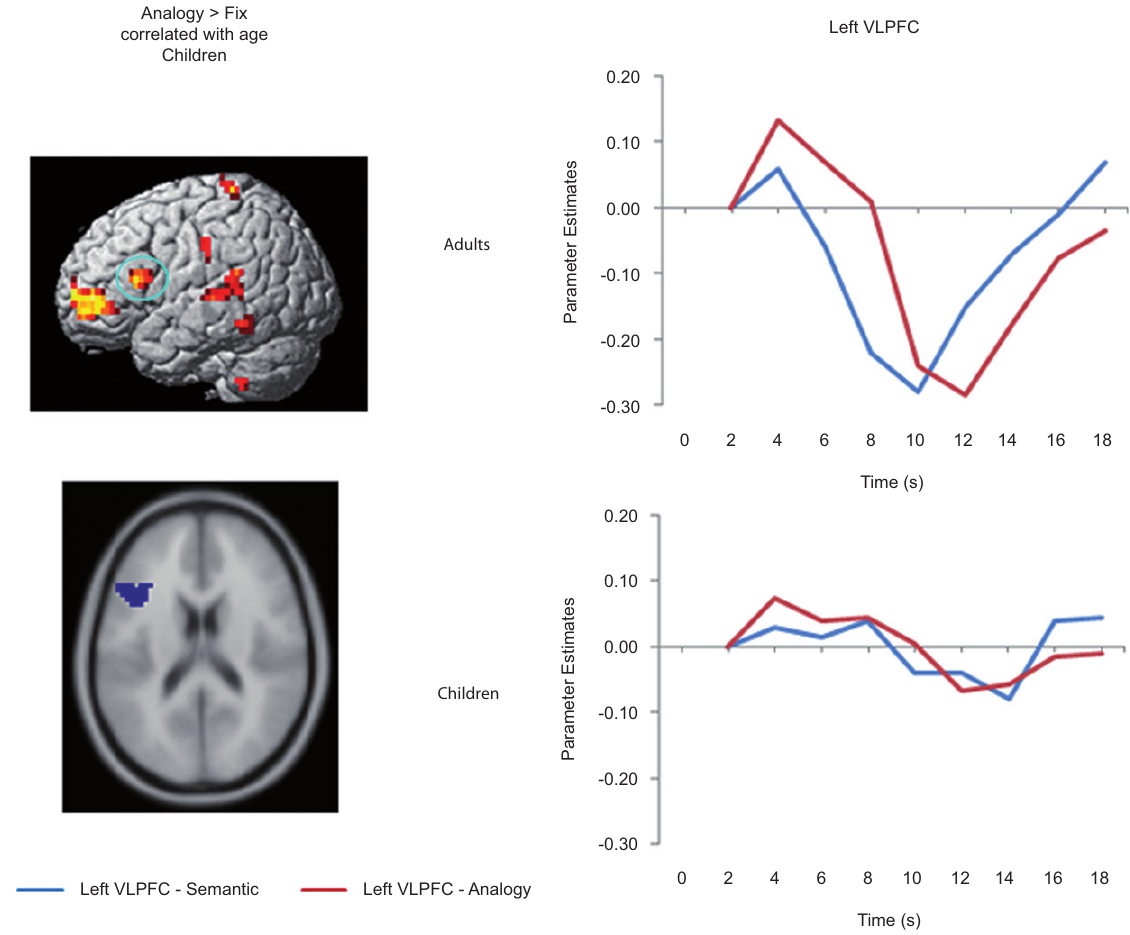
Figure 4. Left VLPFC ROI and timecourse. The left side displays the left VLPFC ROI identifi ed from the positive correlation between semantic > fi xation activation and age in children (ROI circled in blue on the rendered image, and shown below on an axial slice). The right side displays the median timecourse of activation for this region. Semantic (blue) and analogy (red) trials are shown separately, for both adult and child